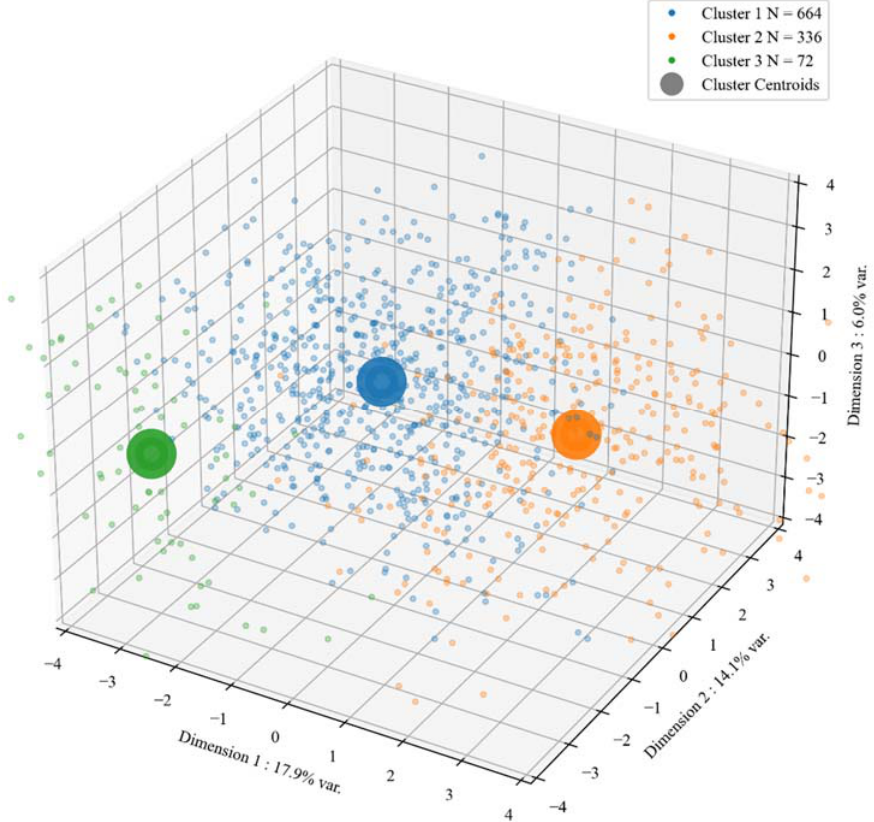
Figure 2. Clusters of the police officers obtained from an optimized spectral clustering algorithm. Each point represents an individual officer’s values on the first ( x -axis), second ( y -axis) and third ( z -axis) principal components of the data (Dim 1, Dim 2, Dim 3). The cluster centroids are calculated as the mean value of the cluster for each of the three dimensions. This diagnostic demonstrates the satisfactory result of within-cluster cohesion and between-cluster separation with respect to the three strongest principal components, as per the total variance they explained (17.9%, 14.1% and 6.0%, respectively).